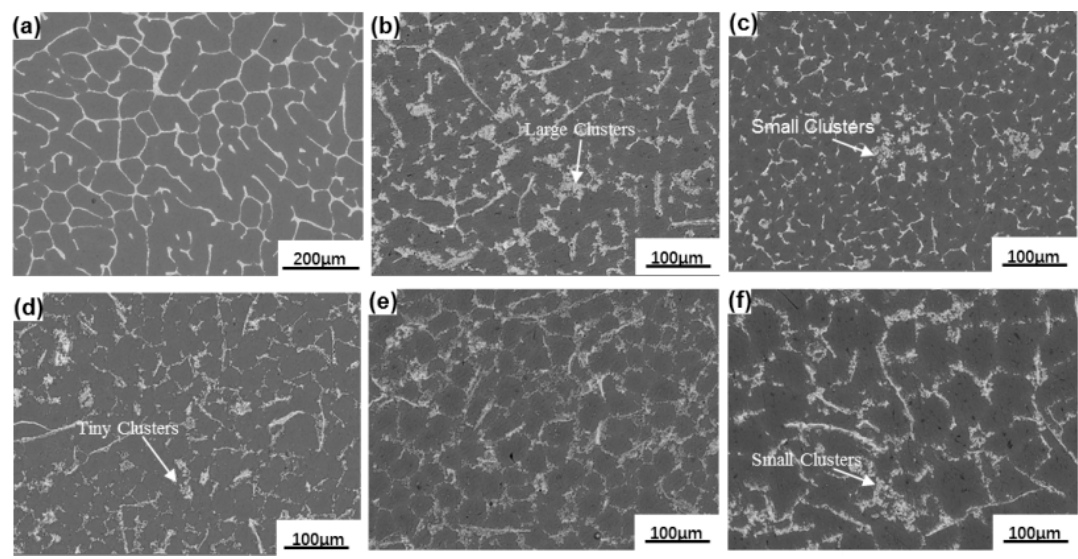
Figure 3. Microstructure of 2A14 matrix ( a ) and TiB 2 /2A14 composites: ( b ) Without ultrasonic vibration treatment (UVT), ( c ) UVT for 30 s, ( d ) UVT for 60 s, ( e ) UVT for 120 s, ( f ) UVT for 240 s.